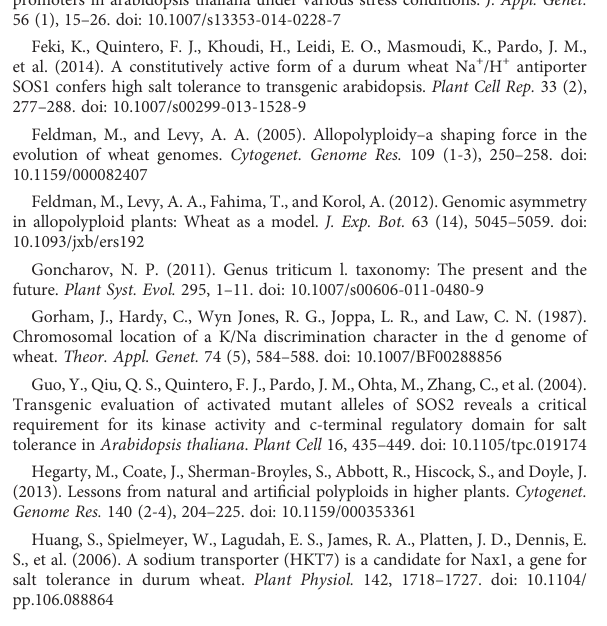
SUPPLEMENTARY FIGURE 4 The cis-acting regulatory elements analysis for promoter sequences of TaSOS1-A , TaSOS1-B , TaSOS1-D genes from hexaploid wheat genotype Nongda3338 using PlantCARE database. Red boxes: presented both in promoters of TaSOS1-A and TaSOS1-B , but absent in TaSOS1-D . Black boxes: presented speci fi cally in promoter of TaSOS1-A . Blue boxes: presented speci fi cally in promoter of TaSOS1-D .